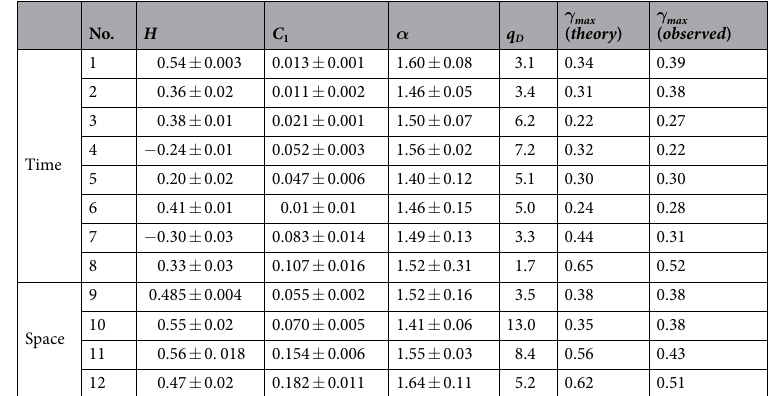
Table 2. The scaling parameters H , C 1 , α and probability exponents q D . The far right columns give theoretical estimates of the maximum spike heights using the parameters C 1 , α , q D and the scale ratio λ of the plots in Fig. 2 ( = 1000 except for data sets 10, 11, 12 where λ = 360, 360, 180 respectively; the spike plot for data set #6 is not shown). The theory column uses these parameters with the multifractal theory described in the text to estimate the solution to the equation c ( γ max ) = 1. The “observed” column determines γ max from the spike plot directly: γ = Δ Δ λ T T log( / ) /log where |Δ | |Δ | T T ( / ) is the maximum spike. For comparison, for λ = 1000, max max max Gaussian probabilities of 10 − 3 , 10 − 6 , 10 − 9 yield respectively γ max = 0.20, 0.26, 0.30. Error estimates for the right hand columns (extremes) were not given due to their sensitivity to the somewhat subjective choice of range over which the regressions were